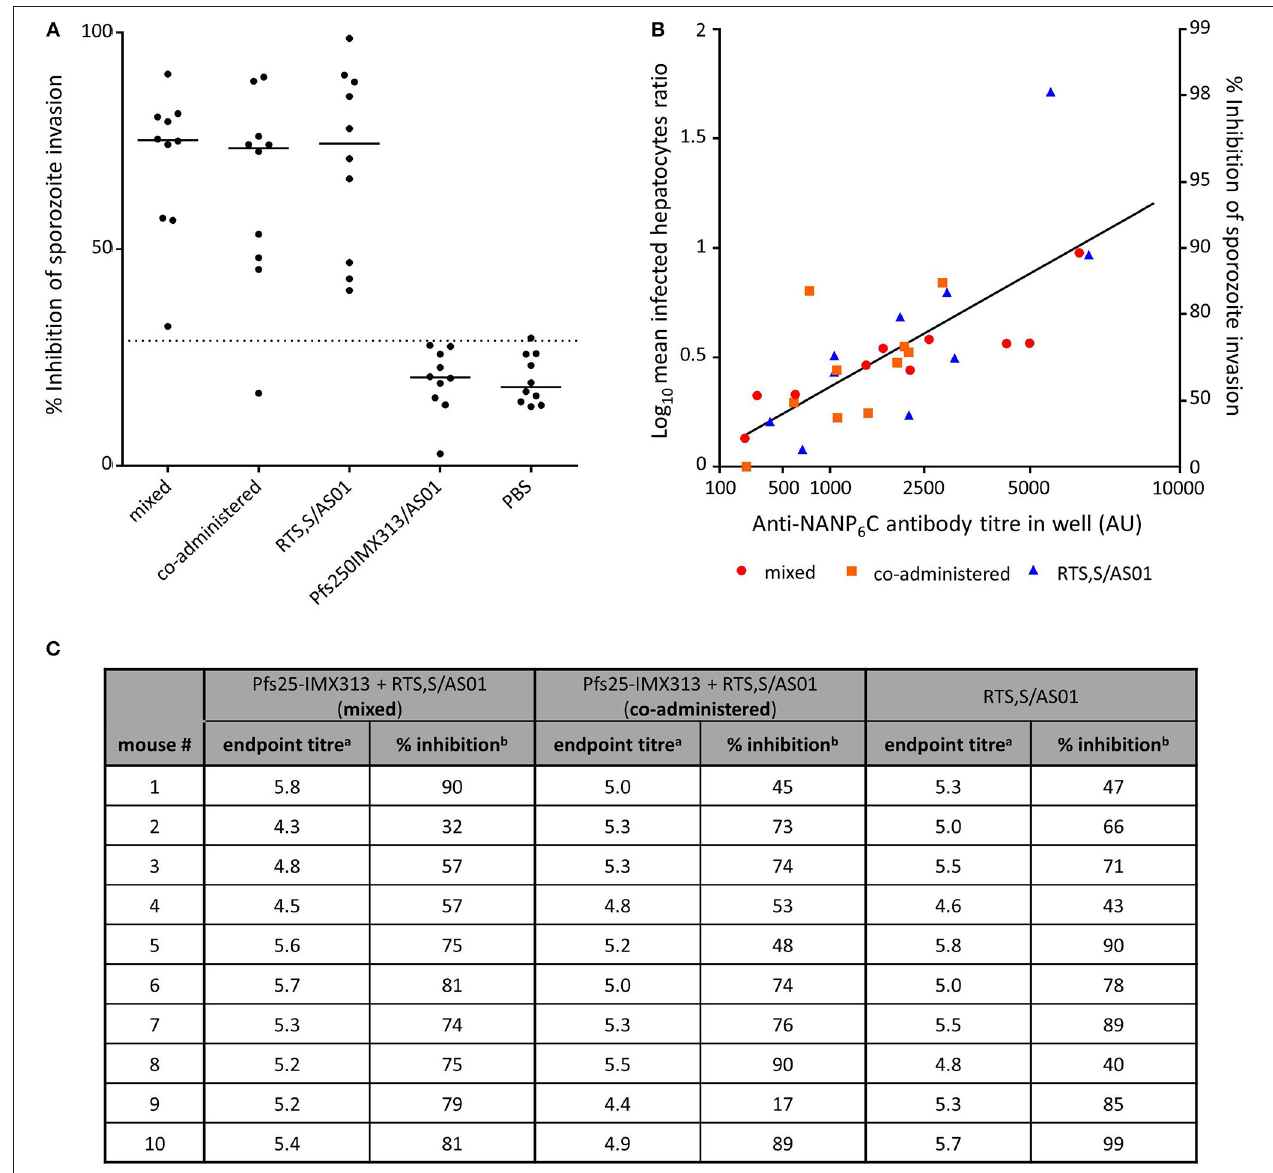
FIGURE 5 | Inhibition of sporozoite invasion by anti CSP-serum induced by immunization with RTS,S alone or in combination with Pfs25-IMX313. (A) Serum from individual mice (2 weeks post boost) was mixed with P. berghei sporozoites from mosquito salivary gland dissections, and the inhibition of sporozoite invasion was assessed. Data points show inhibition of sporozoite invasion by serum from individual mice, lines show the median, the dotted line shows the limit of sensitivity. (B) The quality of anti-CSP serum induced in individual mice was assessed by linear regression analysis, correlating the anti-CSP IgG endpoint titres in the culture medium with the log-transformed ratios of infected hepatocytes in control and test samples (log-mean ratio, LMR). LMR is plotted on the left y-axis. The right y-axis shows the correspondent %ISI. Values on the x-axis are plotted on a square root scale. The black line shows the shared linear fit for IgG from all groups. (C) The induced anti-NANP endpoint titres and the correlating %ISI in individual mice are detailed in the table. a Log10-transformed NANP6C endpoint titres as determined by ELISA. b % Inhibition of sporozoite invasion by 1% serum in culture medium.